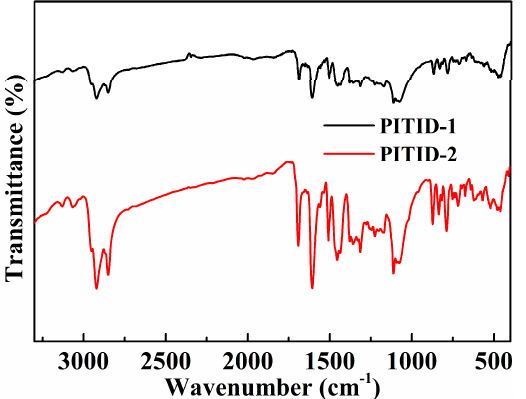
Figure 1. FTIR spectra of the two compounds PITID-1 ( black line ) and PITID-2 ( red line ).